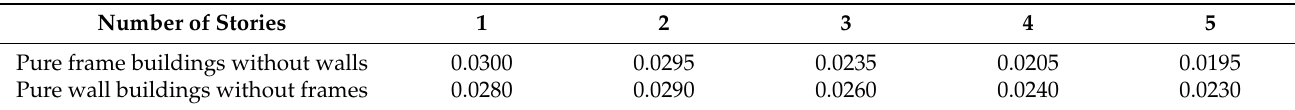
Table 1. Seismic target angular deformation γ t,top of the building at the NC state (mean values), on the top of the vertical axis III sec and along the horizontal axes I sec and II sec . Values for dual systems (frames and walls) or coupled (via beams) wall systems, as well as for different number of stories, can be found by linear interpolation. Number of Stories Pure frame buildings without walls Pure wall buildings without